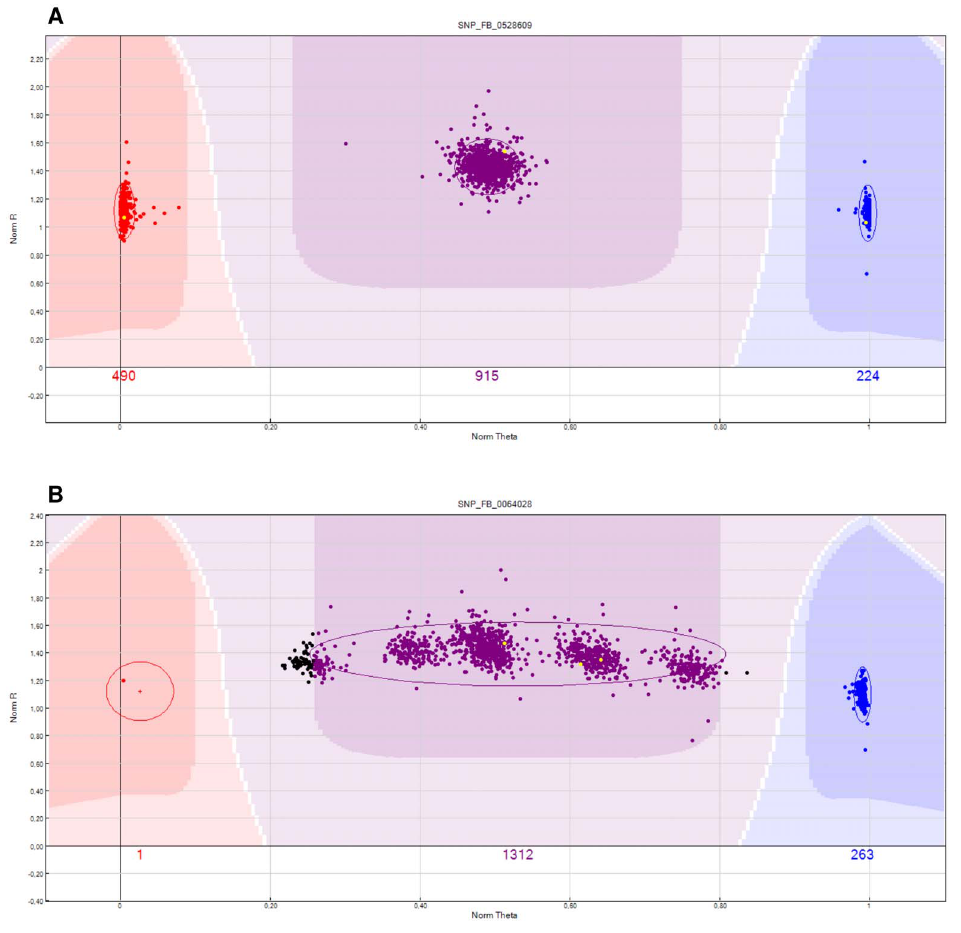
Figure 4. GenomeStudio cluster plot for the 21 F 1 full-sib families used for the construction of genetic maps. Yellow dots indicate panel members that were re-sequenced and used as parents. Genotypes are called for each sample (dot) by their signal intensity (norm R) and Allele Frequency (Norm Theta) relative to canonical cluster positions (dark shading) for a given SNP marker (red=AA, purple=AB, blue=BB) a) GenomeStudio cluster plot of a newly developed robust SNP marker. b) GenomeStudio cluster plot of a failed/difficult to score SNP marker.